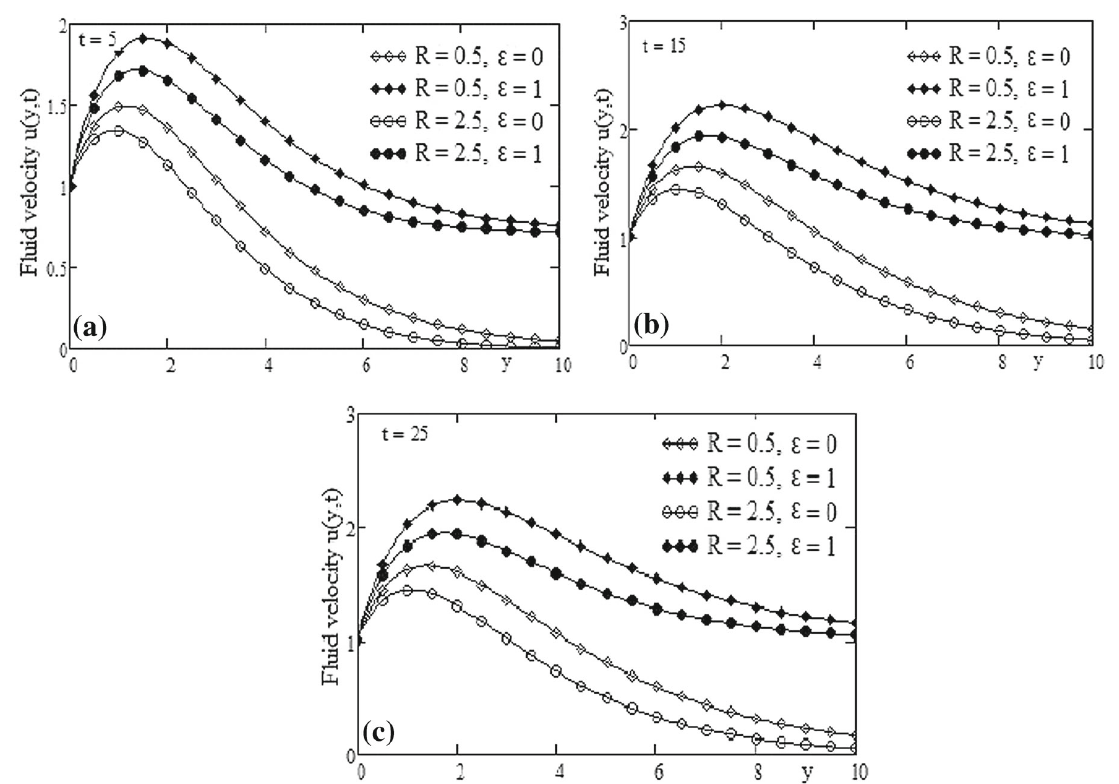
Fig. 4 Profiles of the dimensionless velocity given by Eq. (25) for Pr = 0 . 71, Q = 0 . 6, Sc = 0 . 2, M = 0 . 25, Gr = 1 . 25, Gm = 0 . 5, R = 0 . 5 and 2.5 and different values of time t